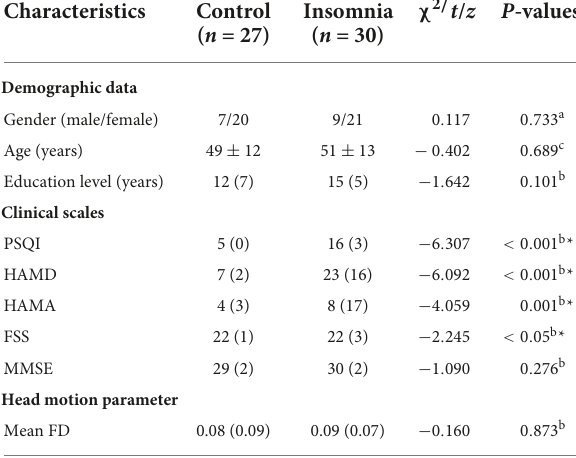
TABLE 1 Demographic and clinical information of subjects.